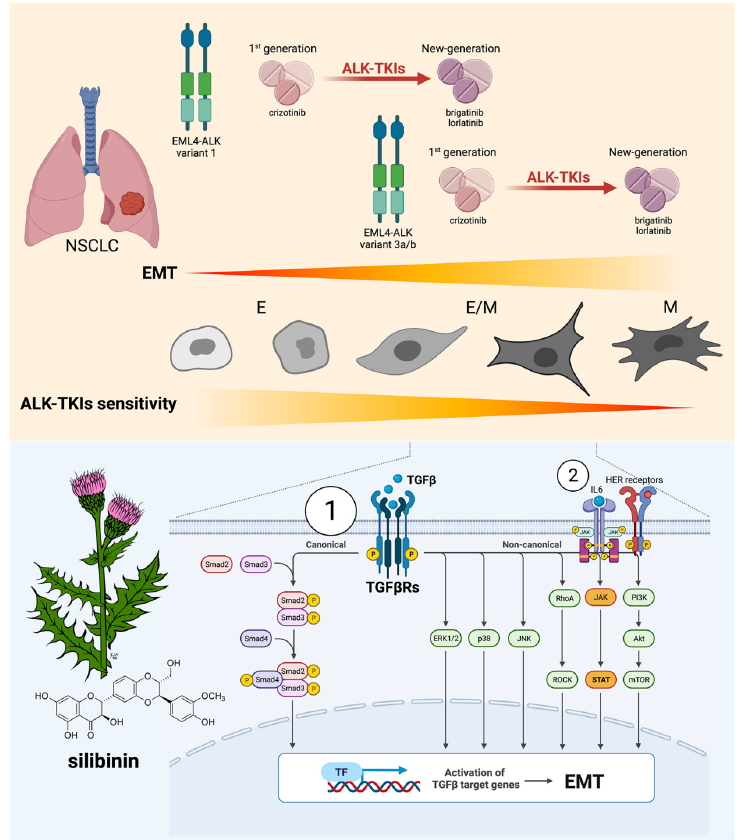
Figure 6. EMT ‐ ness and resistance to multiple ‐ generation ALK–TKIs: a therapeutic opportunity for silibinin. Top: The plasticity along the EMT spectrum might determine the propensity of ALK ‐ rear ‐ ranged NSCLC cells to exhibit cross ‐ resistance to multiple ‐ generation ALK–TKIs. The more epithe ‐ lial an ALK ‐ rearranged NSCLC cell population is (e.g., EML4 ‐ ALK variant 1), the lower the capacity to acquire a mesenchymal phenotype refractory to new ‐ generation ALK–TKIs, and vice versa, the more mesenchymal an ALK ‐ rearranged NSCLC cell population is (e.g., EML4 ‐ ALK variant 3a/b), the higher the capacity to acquire a mesenchymal phenotype refractory to new ‐ generation ALK– TKIs . ALK ‐ rearranged NSCLC cells gaining a bona fide mesenchymal phenotype caused by a late, full EMT upon chronic exposure to crizotinib, but not those acquiring only a partial/hybrid E/M transition state, exhibit an augmented resistance to the 2nd generation ALK–TKI brigatinib and complete refractoriness to the 3rd generation ALK–TKI lorlatinib. Bottom: The flavonolignan silibinin can overcome EMT ‐ driven cross ‐ resistance to new ‐ generation ALK–TKIs by attenuating the hyperactivation of the TGF β /SMAD signaling axis ( 1 ). Nonetheless, silibinin can exert additional ALK–TKIs sensitizing effects via direct inhibition of STAT3 [75] and EGFR [76] ( 2 ), thereby prevent ‐ ing a functional landscape of resistance to ALK inhibition in NSCLC involving the activation of the IL6/JAK1/STAT3 [77] and HER [78] signaling pathways. Created with Biorender.com.